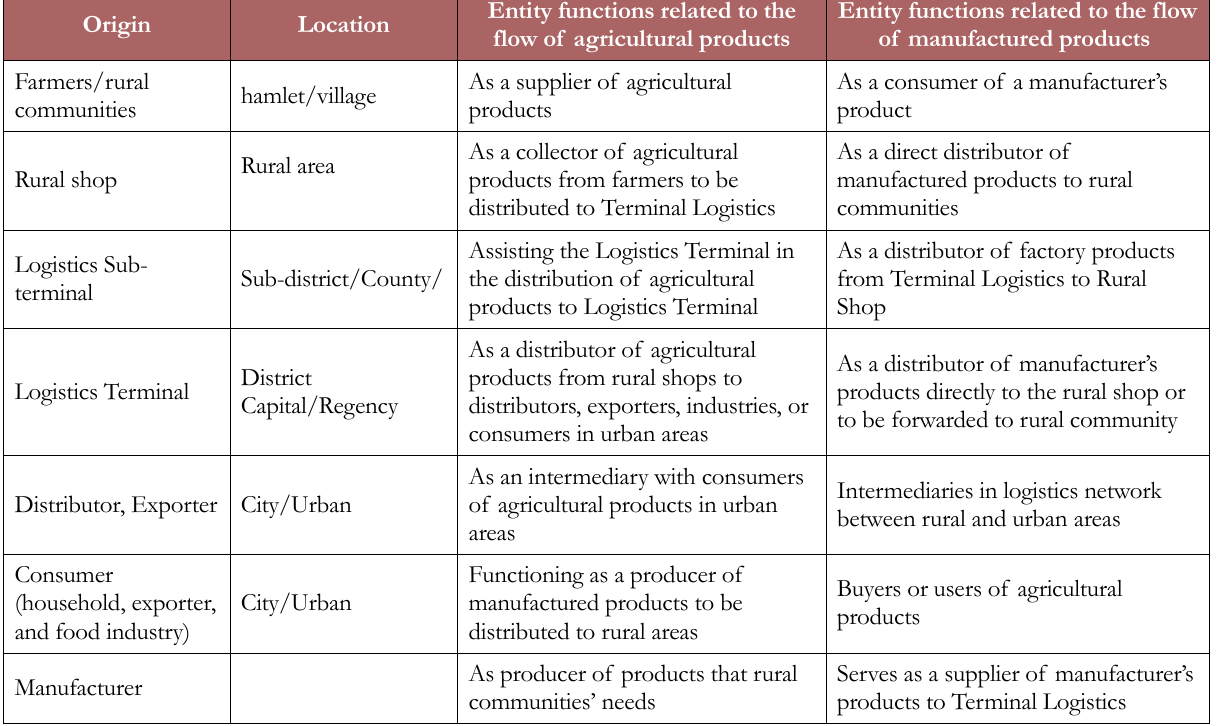
Table 5. Network entities used in the rural logistics